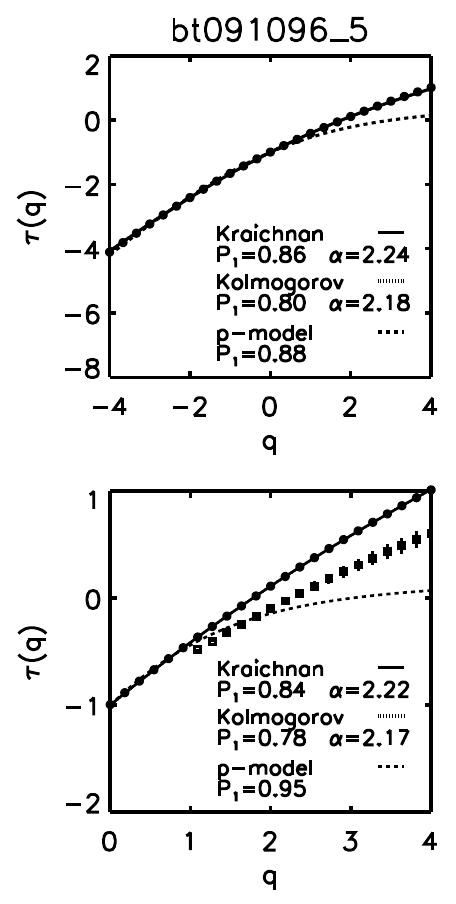
Fig. 4. Comparison between the experimental τ(q) (dots) and best- fit model scaling exponent. The bottom plot shows the results of fitting for τ(q) limited to q> 0 and, for comparison, the scaling ex- ponent of the structure function (squares). The error bars give the standard deviations of the least-squares fits. In spite of different pa- rameters, curves for Kraichnan-like and Kolmogorov-like models are practically indistinguishable on this plot.